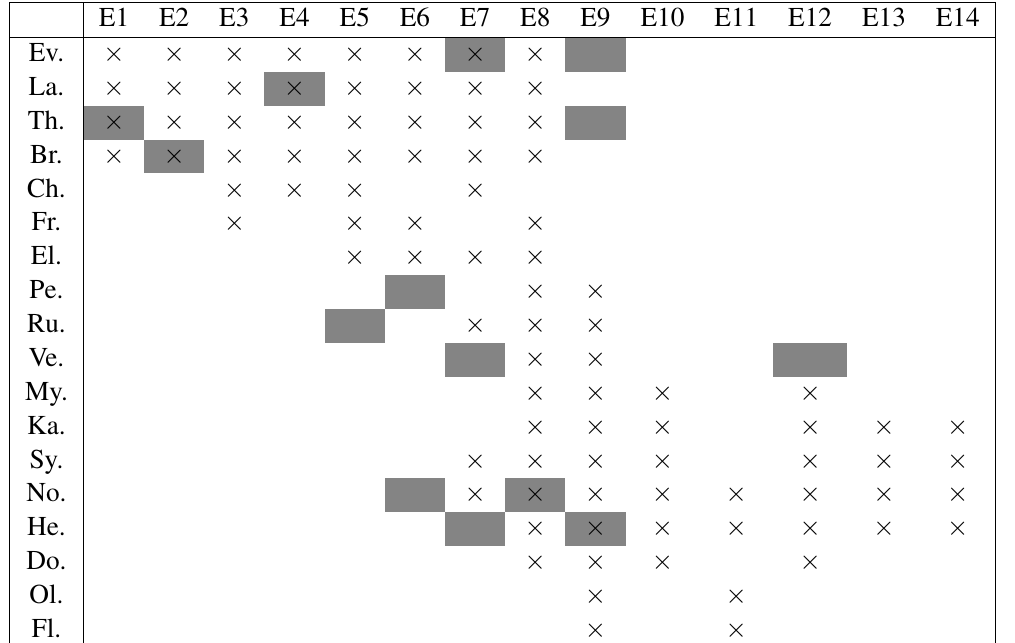
Table 2: New relation from southern woman bipartite network after applying random walk transformation. Cells in gray are the ones affected by the